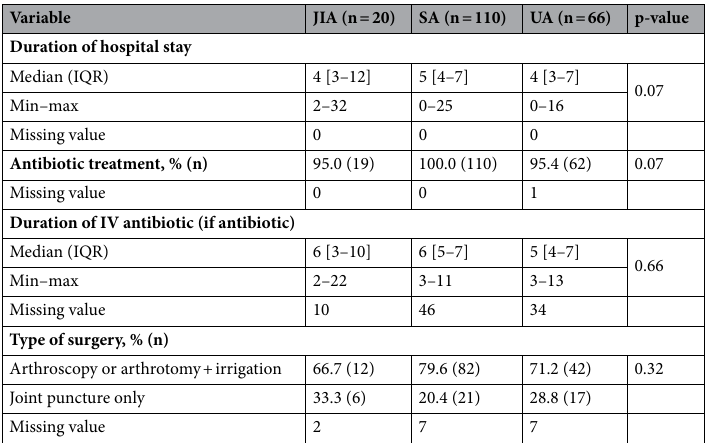
Table 3. Follow-up children with septic arthritis, JIA and arthritis with no definitive diagnosis. SA septic arthritis, JIA juvenile idiopathic arthritis, UA undetermined arthritis a , IQR interquartile range. a Arthritis with no established association with infection that did not fulfil the classification criteria for JIA or other well- established diagnoses.